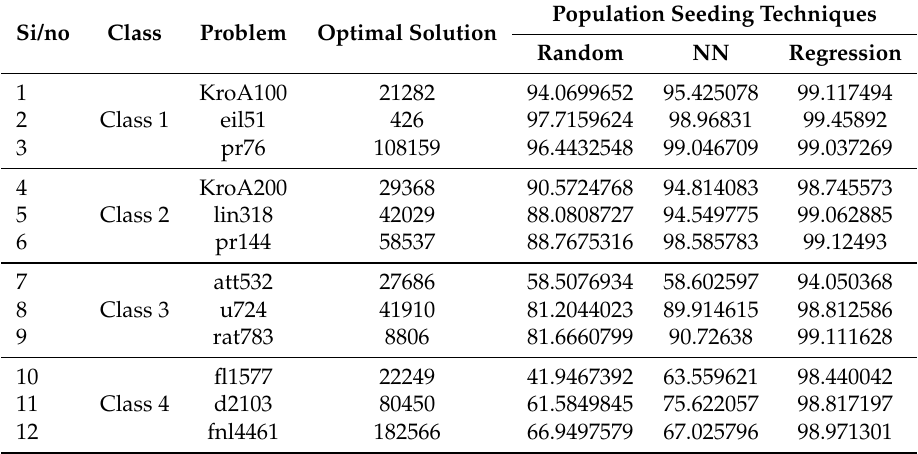
Table 8. Average convergence (%) rate results for Random, NN and our regression-based